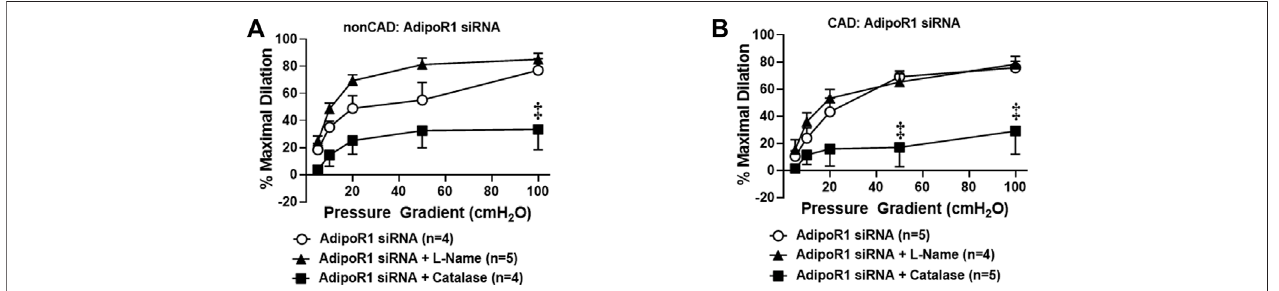
FIGURE3| RoleofAdipoR1inFIDwithinthehumanmicrovasculature. (A) FIDinnonCADarterioleswithreducedexpressionofAdipoR1wassigni fi cantlyimpaired in the presence ofPEG-catalase( n =4) compared tosiAdipoR1 alone ( n = 4, ‡ p < 0.01) whereas L-NAMEhad no effect( n =5). (B) Dilation to fl ow inarterioles from CAD subjects treated with siAdipoR1 and PEG-Catalase ( n = 5) was signi fi cantly decreased compared to vessels treated with siAdipoR1 alone ( n = 6, ‡ p < 0.01), however L-Name had no effect ( n = 4).